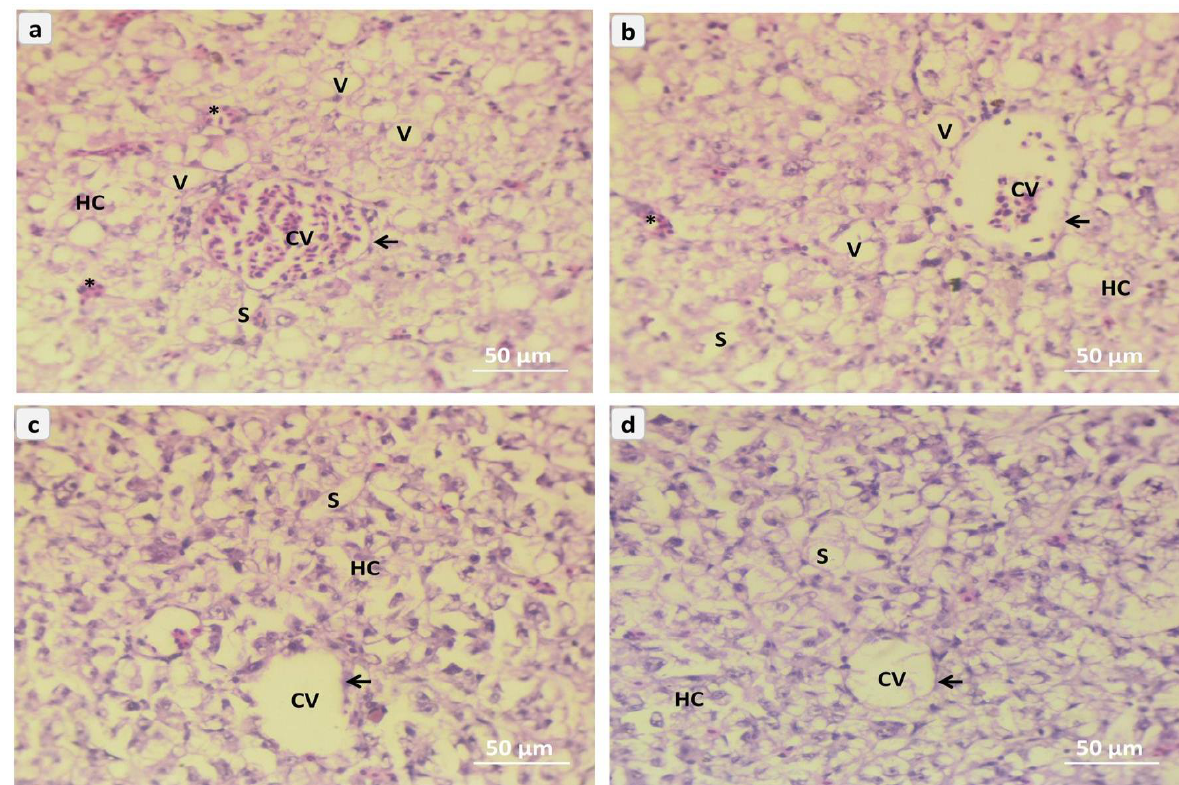
Figure 3. Representative micrograph of liver sections of red tilapia ( Oreochromis sp . ) challenged with Aspergillus flavus , ( a ) → NC0, ( b ) → NC1, ( c ) → NC2, ( d ) → NC3. NC0: control diet; NC1: nanocurcumin 40 mg/kg diet; NC2: nanocurcumin 50 mg/kg diet; NC3: nano curcumin 60 mg/kg diet. CV = central hepatic vein, arrows = endothelium layer, HC = Hepatocytes, S = hepatic sinusoid, asterisk = inflammatory cells, and V = vacuoles. (H&E, Bar = 50 µm).